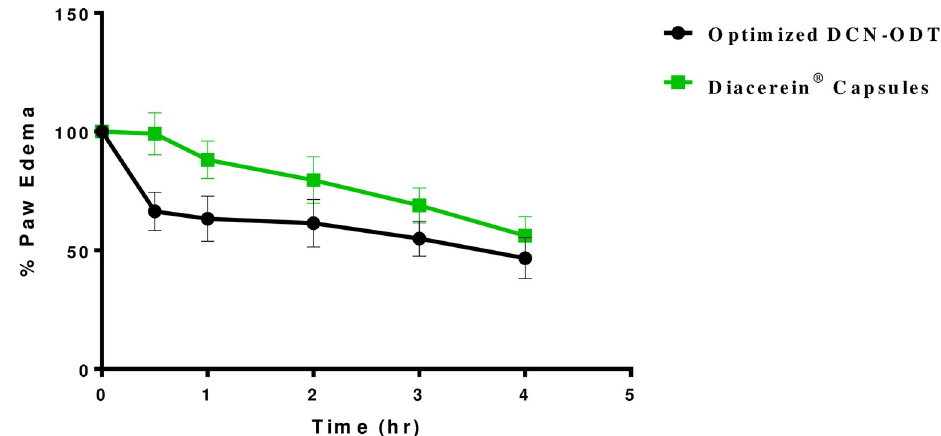
Fig 5. Anti-inflammatory activity of optimized DCN-ODT compared to Diacerein 1 capsules using the rat paw edema model.